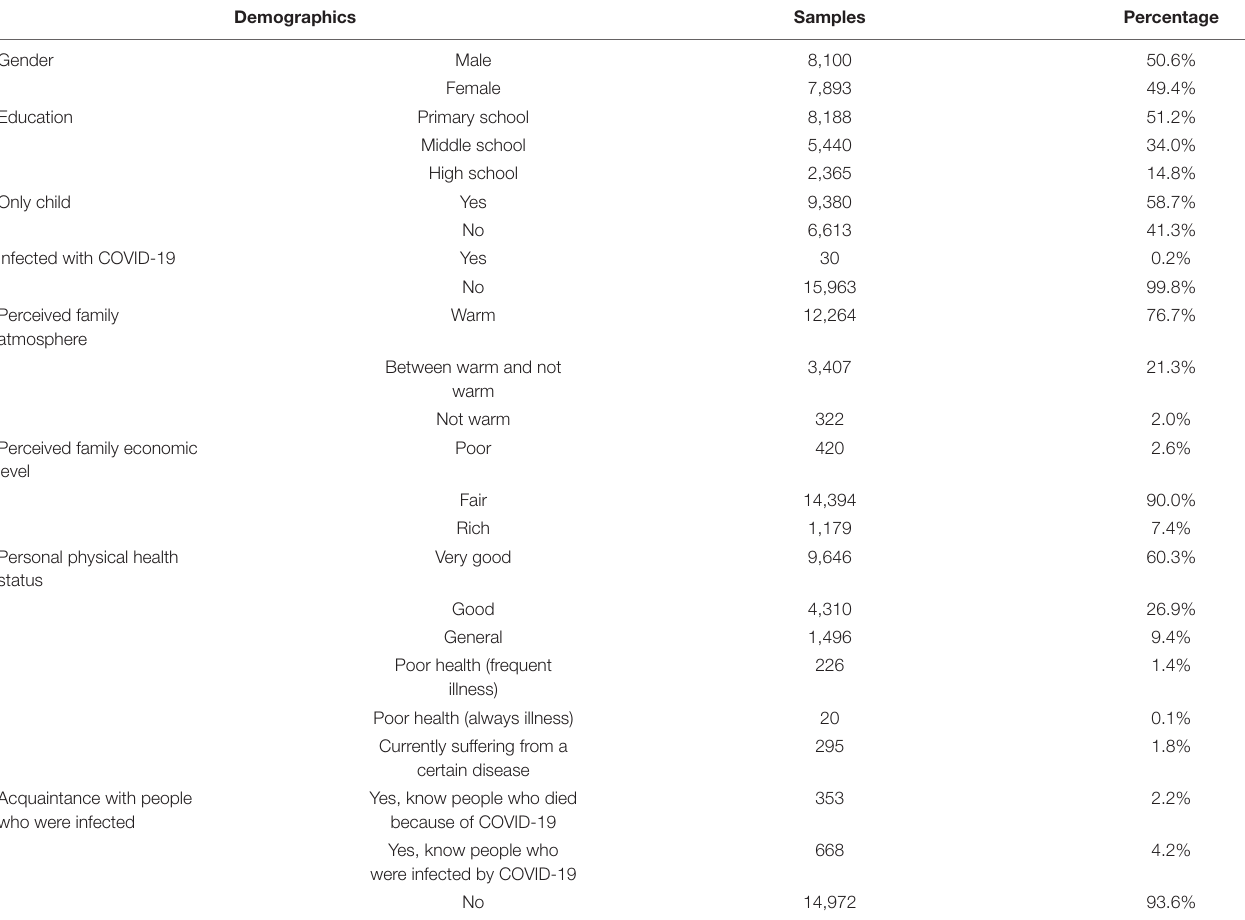
TABLE 1 | Characteristics of study participants ( N = 15,993).